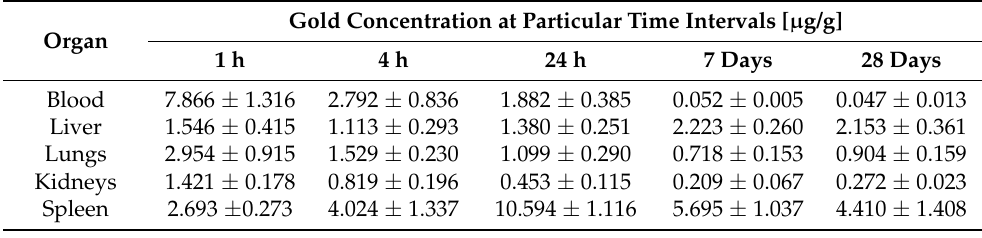
Table 4. Gold amount in blood and organs per gram of tissue determined by GFAAS in rats at